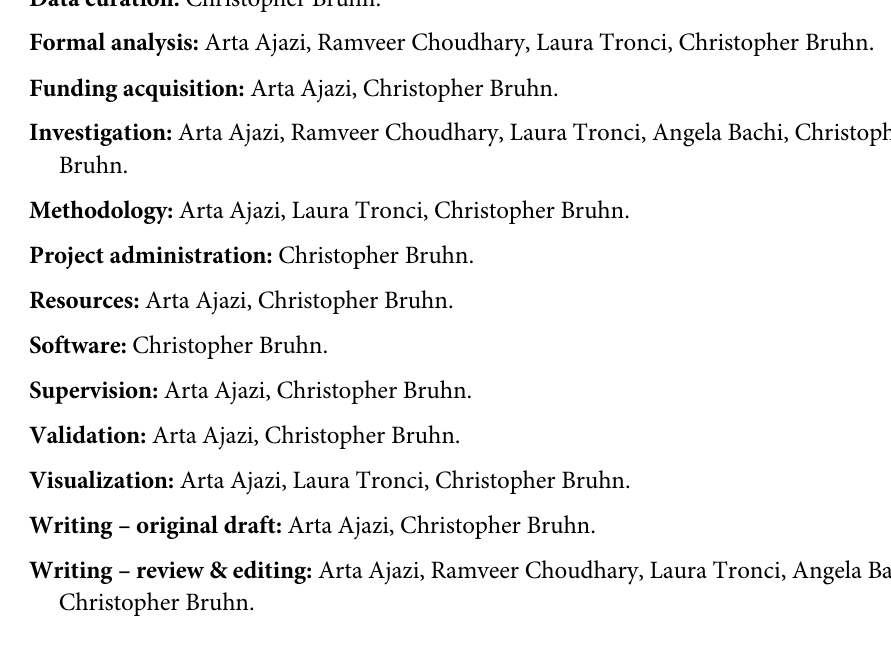
S4 Table. Yeast knock-out library colony sizes on YPD and YPD + DON in the ura8 Δ back- ground. S5 Table. Yeast strains used in this study. S6 Table. Primers used in this